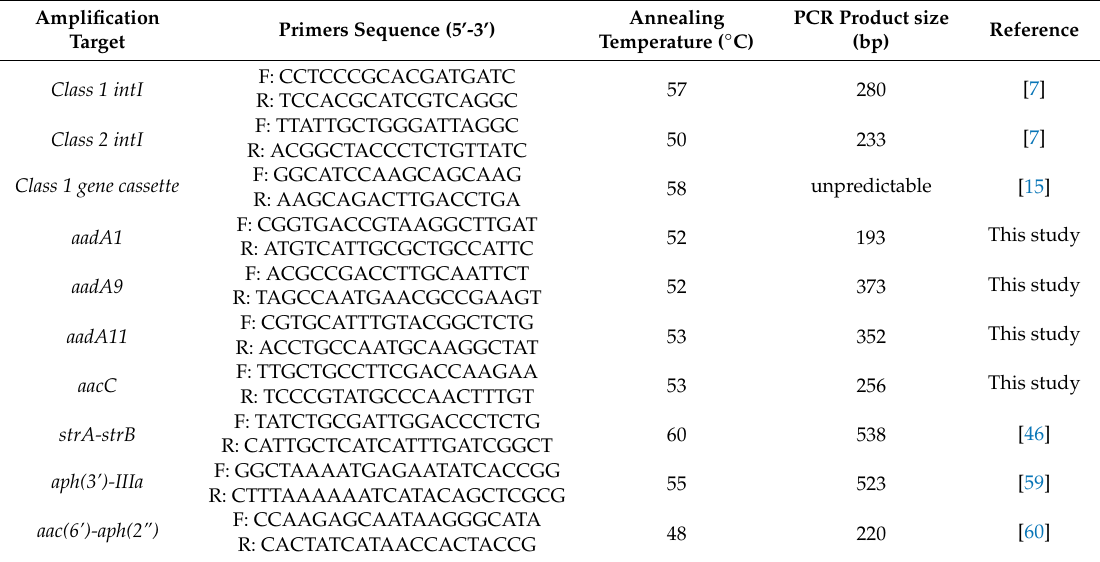
Table 4. Primers used in this